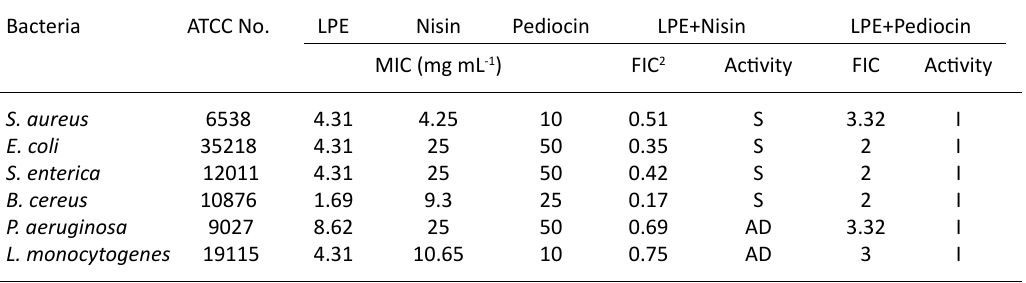
Table 2. Synergistic activity of lipopeptides extract (LPE) from B. amyloliquefaciens MTCC 10456 with nisin and pediocin against tested bacterial pathogens